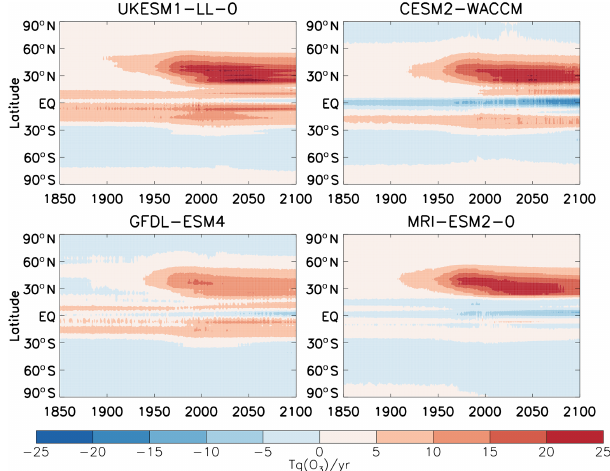
Figure 13. Evolution of net chemical production (red line), dry de- position (black line) and residual ozone budget (blue line) over the period 1850–2100 for UKESM1-0-LL, CESM2-WACCM, GFDL- ESM4 and MRI-ESM2-0.